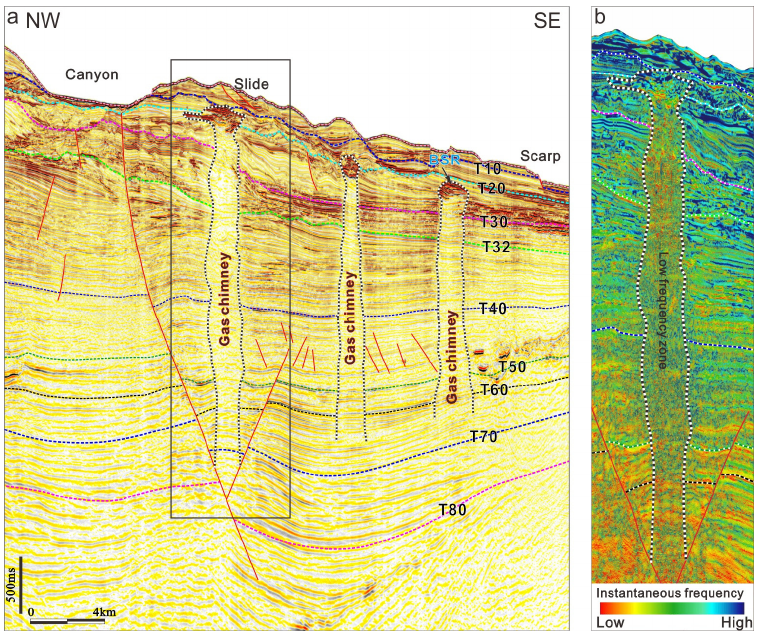
Figure 7. ( a ) Typical features of gas chimneys in the general seismic profile; ( b ) Features of gas chimney on instantaneous frequency attribute profile, in which a low frequency zone (especially at the upper part of the gas chimney) could be found.